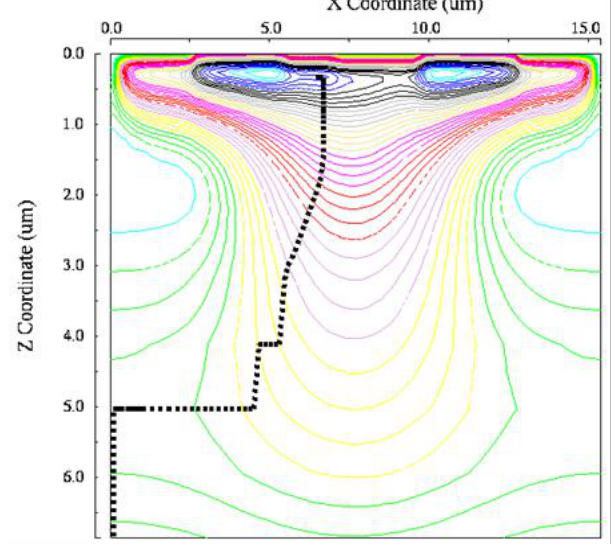
Figure 13. Selective collection of an electron generated at the ―left‖ corner by the ―left‖ collection gate (0 < z < 6.9